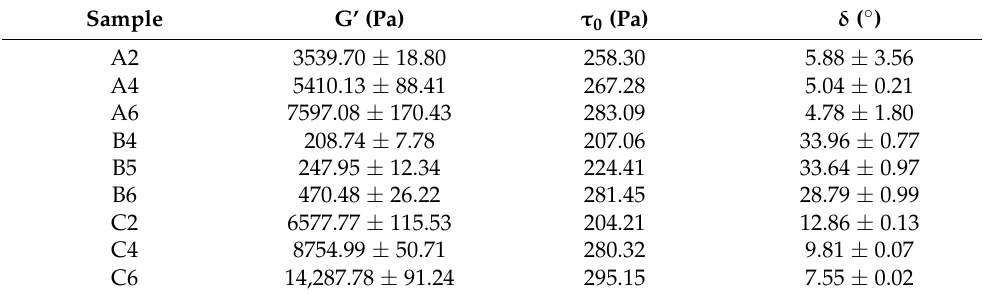
Table 4. Rheological parameters for the fidelity, shape retention, and extrudability of the gel formula- tions as a function of the gelatin, pectin, gum mixture, sugar, and citric acid contents. Sample G’ (Pa) τ 0 (Pa) δ ( ◦ ) A2 3539.70 ± 18.80 258.30 A4 5410.13 ±